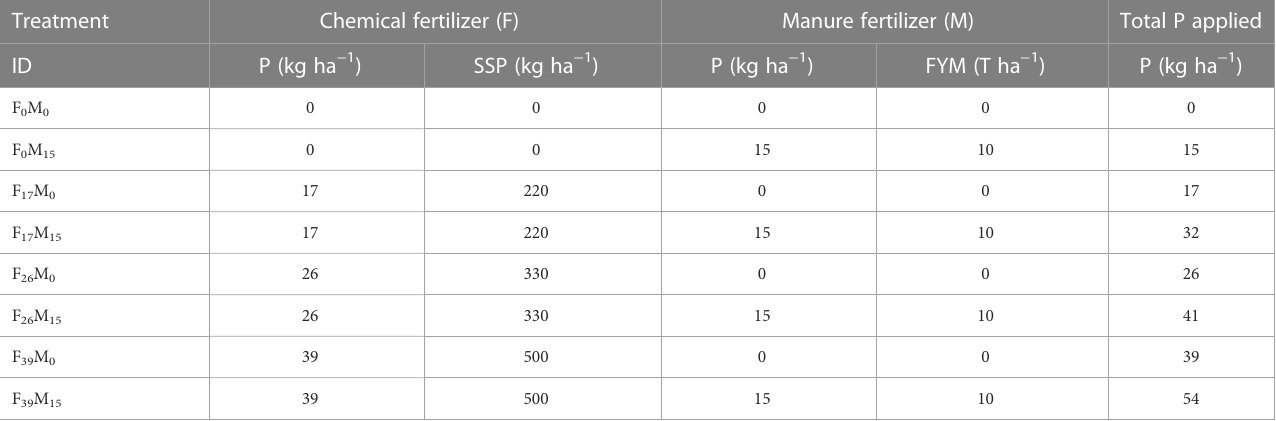
TABLE 1 Phosphorus (P) treatment rates (kg ha − 1 ) applied as single superphosphate (SSP) and/or farmyard manure (FYM) for a laboratory and a fi eld experiment. Treatment Chemical fertilizer